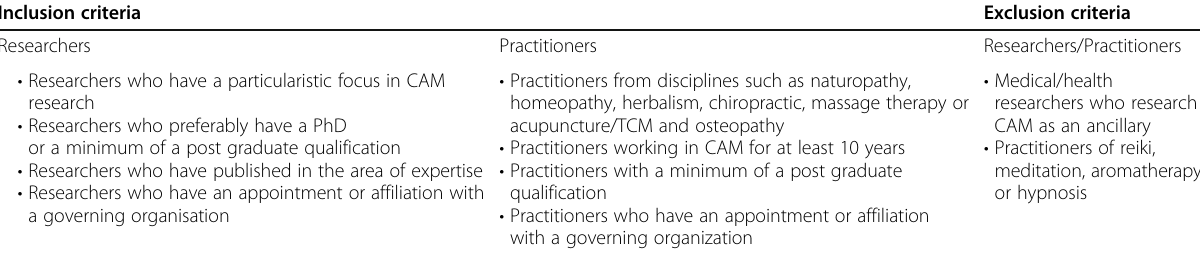
Table 1 Overview of the participant inclusion & exclusion criteria Inclusion